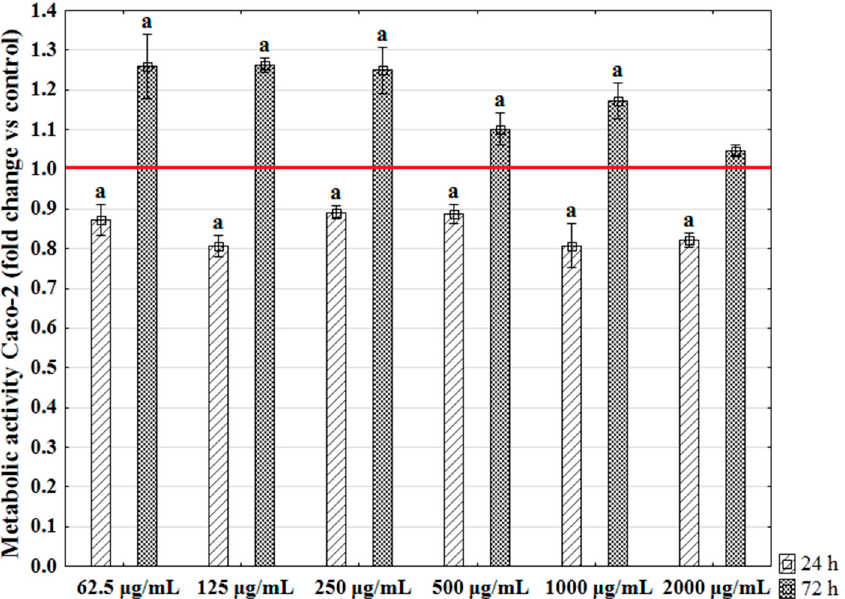
Figure 2. The influence of the E. prolifera extracts on Caco-2 metabolic activity. The statistically significant differences were tested at p level 0.05 (statistically significant difference marked as “a”). The normative value was determined based on a control culture’s metabolic activity (red line).